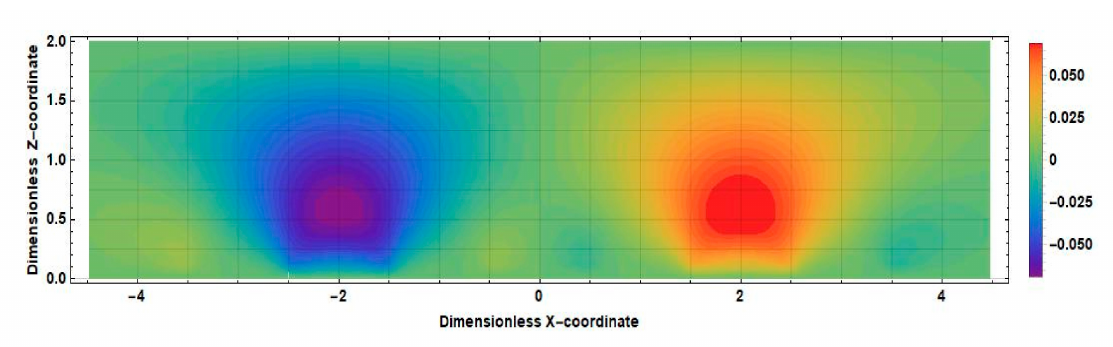
∂ c ~ 0 ( ˜ x ,˜ z ) v ~ ∂ ˜ x in an electrochemical cell at x